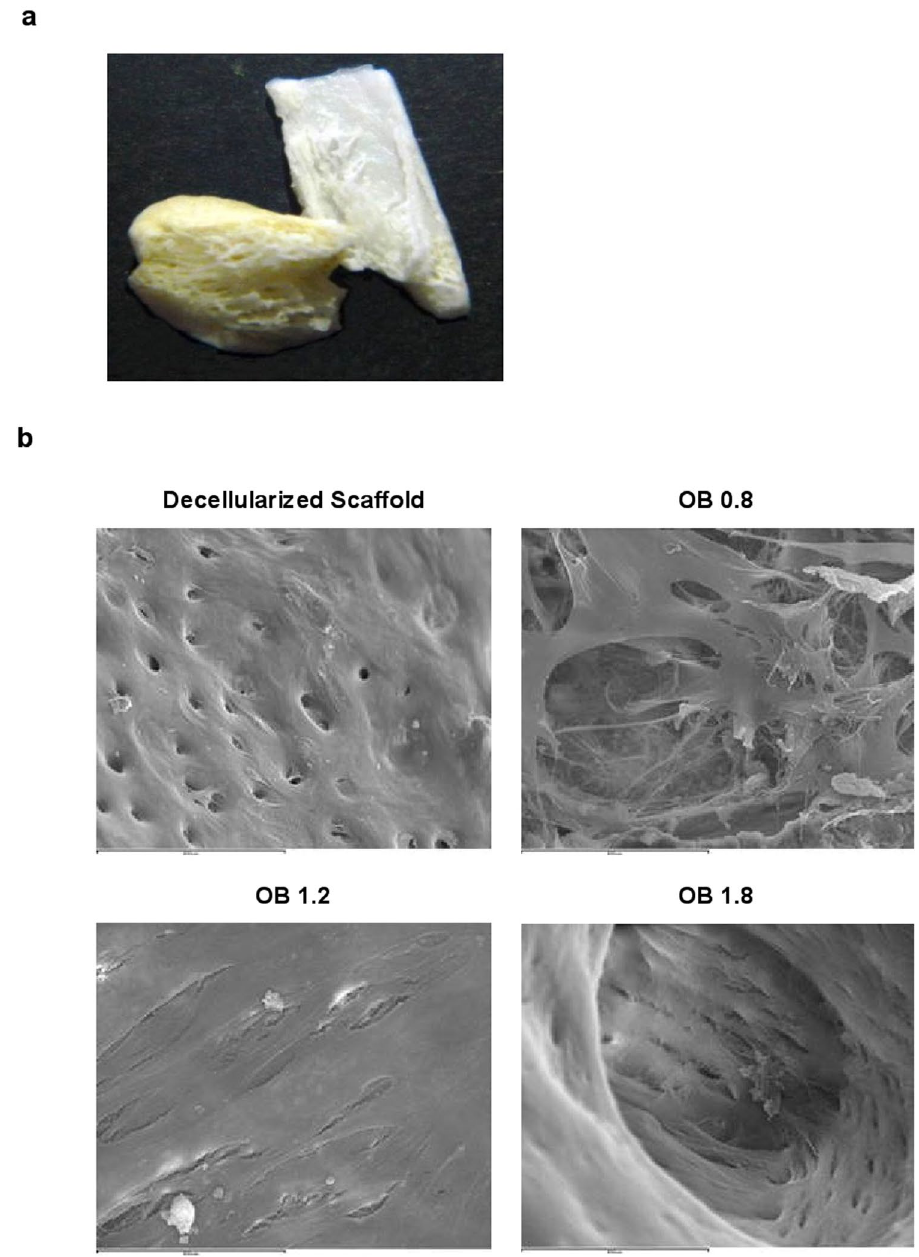
Figure 5. MgCl 2 supplementation promotes attachment and osteogenesis of MSC on decellularized bone scaffolds. ( a ) Macroscopic picture of rat decellularized bone scaffolds used in this study. Pictures show SEM images of ( b ) decellularized bone scaffold, ( c ) re-cellularizated scaffolds after 21 days of osteogenic differentiation with basal Mg 2 + (0.8 mM), where spindle-shaped cells attached to the scaffold were observed. Mineralization, cell attachment and proliferation were enhanced dose-dependently as it is showed in ( d ) Mg 2 + 1.2 mM and ( e ) Mg 2 + 1.8 mM. Scale bar 800 µ